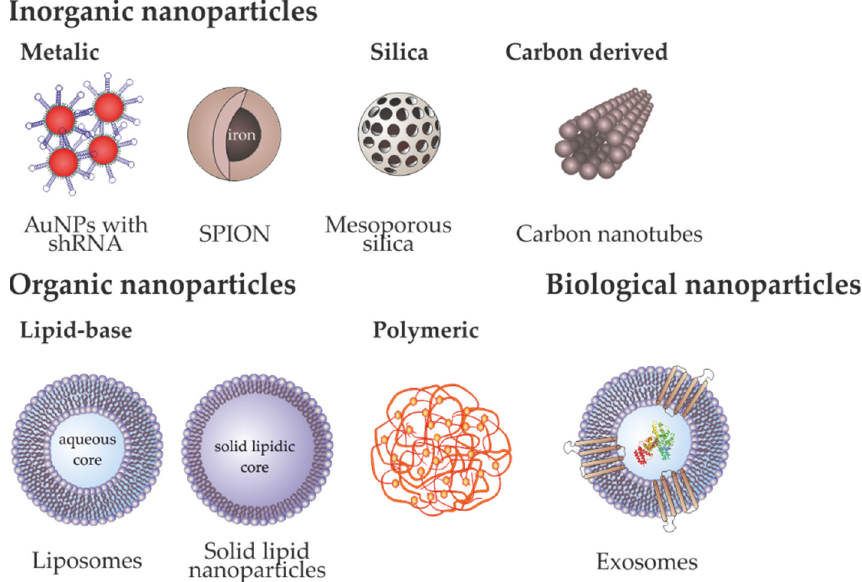
Figure 4. Nanoparticles used for gene delivery. Examples of metallic nanoparticles are gold nanoparticles (AuNPs) that can be functionalized with several molecules, e.g., short hairpin RNA (shRNA) for gene silencing. Other examples of inorganic nanoparticles are superparamagnetic iron oxide nanoparticles (SPION) containing an iron core coated with biocompatible polymers, mesoporous silica nanoparticles or carbon nanotubes. Examples of organic nanoparticles are polymeric nanoparticles, and liposomes and solid lipid nanoparticles (SLNs), which are lipid-base nanoparticles that differ mainly in the aqueous and lipidic core and the number of lipid layers. Exosomes are nanovesicles secreted by eukaryotic cells composed by a bi-lipidic membrane containing membrane proteins, that surround an aqueous lumen containing proteins and nucleic acids.